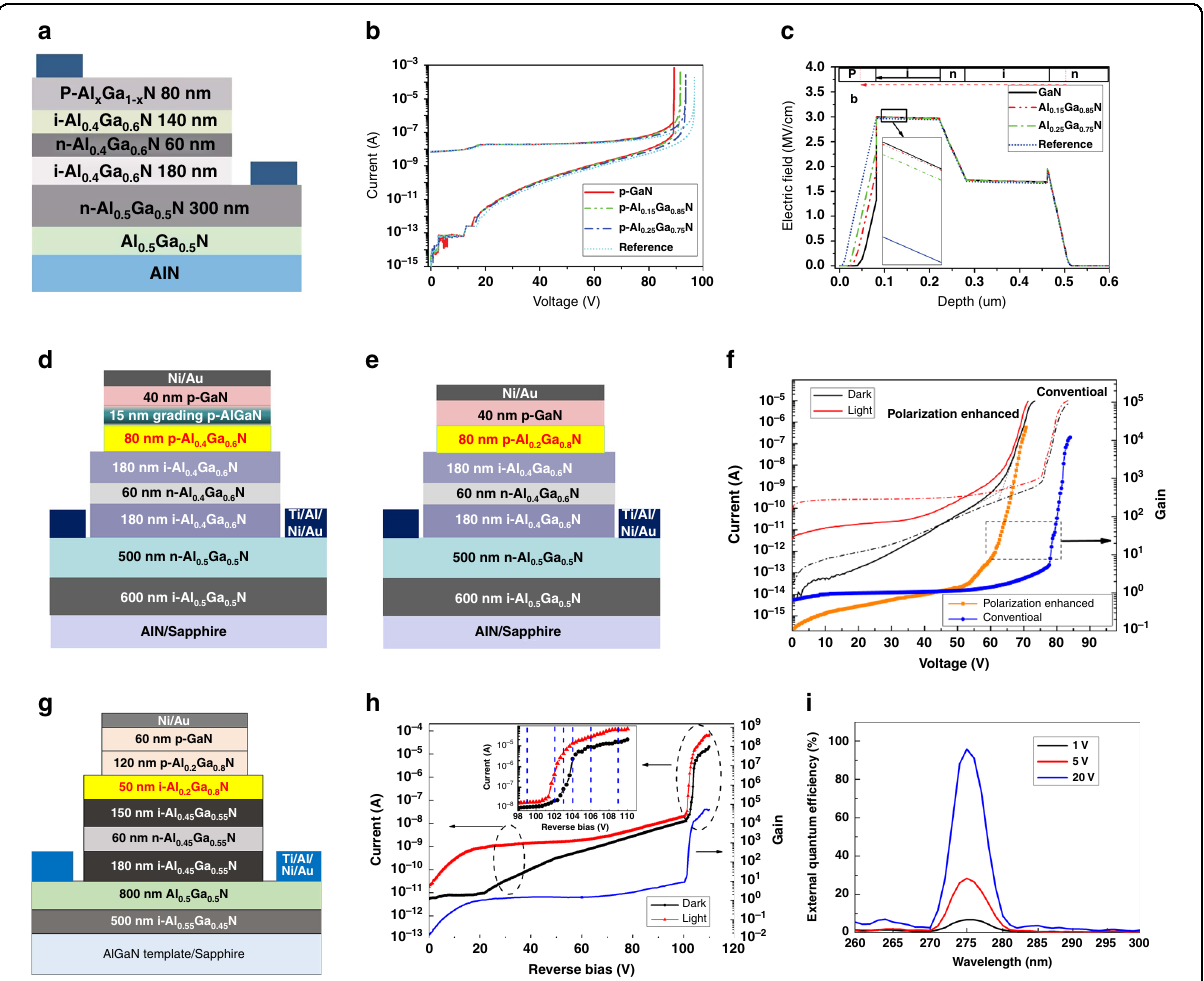
Fig. 15 Polarization engineering for improving device performance. Schematic structures of various back-illuminated SAM APDs: a simulated polarization-enhanced, d , e conventional counterpart and experimental polarization-enhanced, g ionization-enhanced. b , f , h The I-V and gain curves of the proposed APDs, respectively, transverse corresponding. c Electric fi eld distribution of sample a. i EQE of sample g . Reprinted with